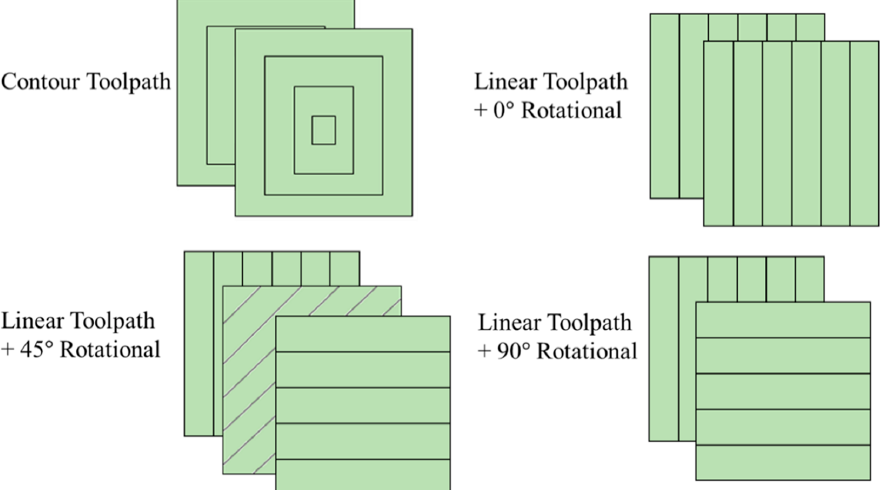
Figure 5. Linear and contour toolpaths in a square.